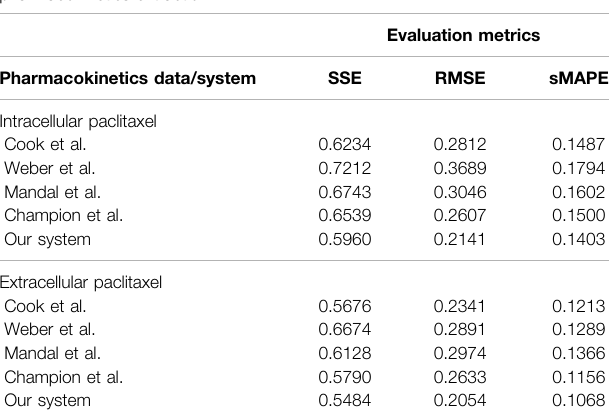
TABLE 7 | Evaluation of the data-driven relation learning systems for pharmacokinetics